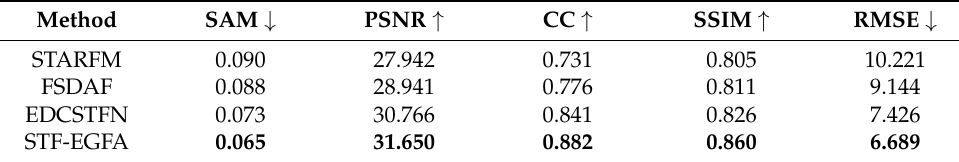
Table 4. Objective evaluation of the Daxing test